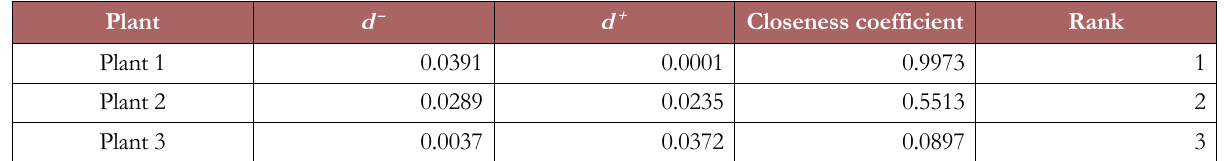
Table 8. Distance, closeness coefficient and the rank of each plant (AR)